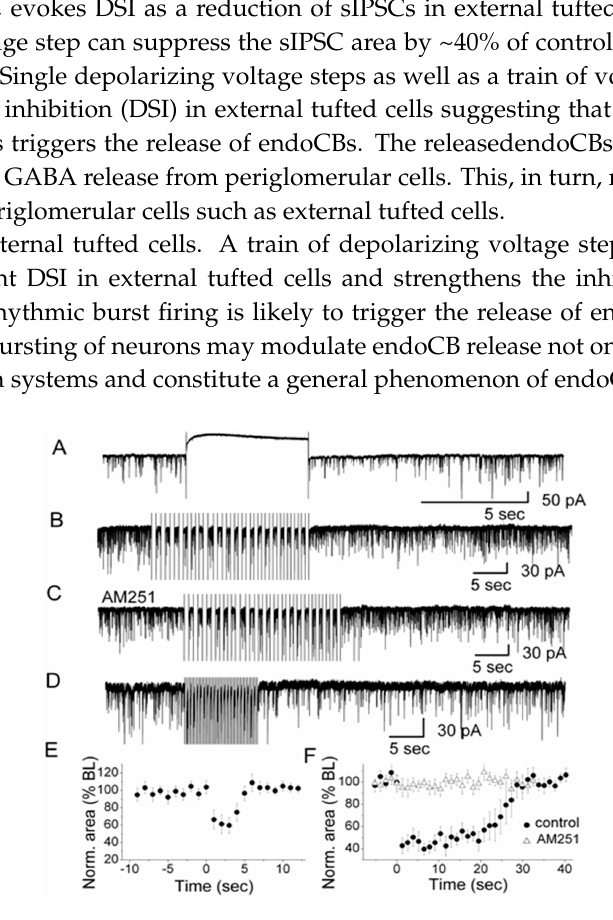
Figure 3. Depolarization-induced Suppression of Inhibition (DSI) in olfactory glomeruli. Depolarization-induced Suppression of Inhibition (DSI) in olfactory